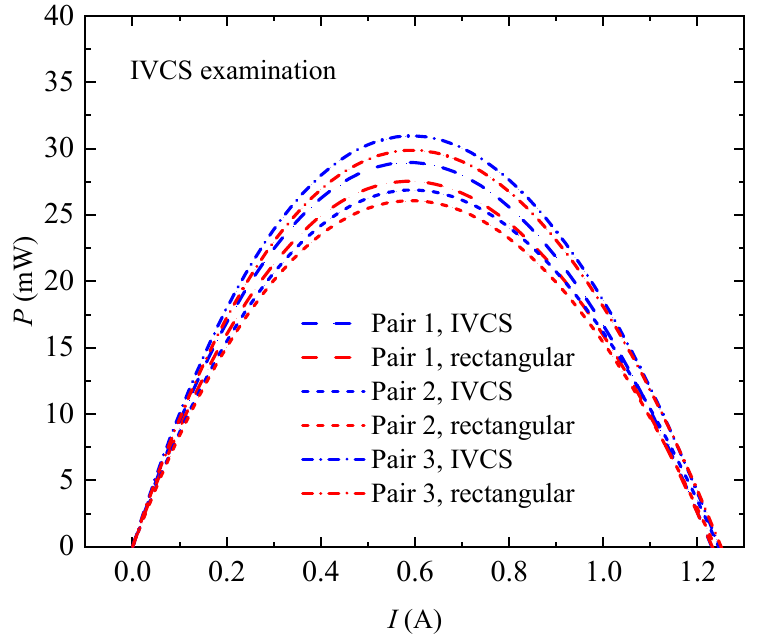
Figure 5. Unit power as a function of current with various cross-sectional designs compared with the rectangular structure. Table 2. Design parameters of the three IVCS patterns shown in Figure 5.